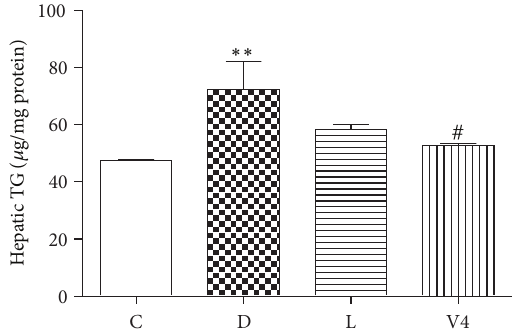
Figure 2: Effects of V 4 dipic-Cl on hepatic TG level in STZ-induced diabetic rats. C: control group, D: diabetic group, L: H 2 dipic-Cl- treated group, V4: V 4 dipic-Cl-treated group. Values are expressed as mean ± SEM, 𝑛 = 3 . ∗∗ 𝑃 < 0.01 versus C. # 𝑃 < 0.05 versus